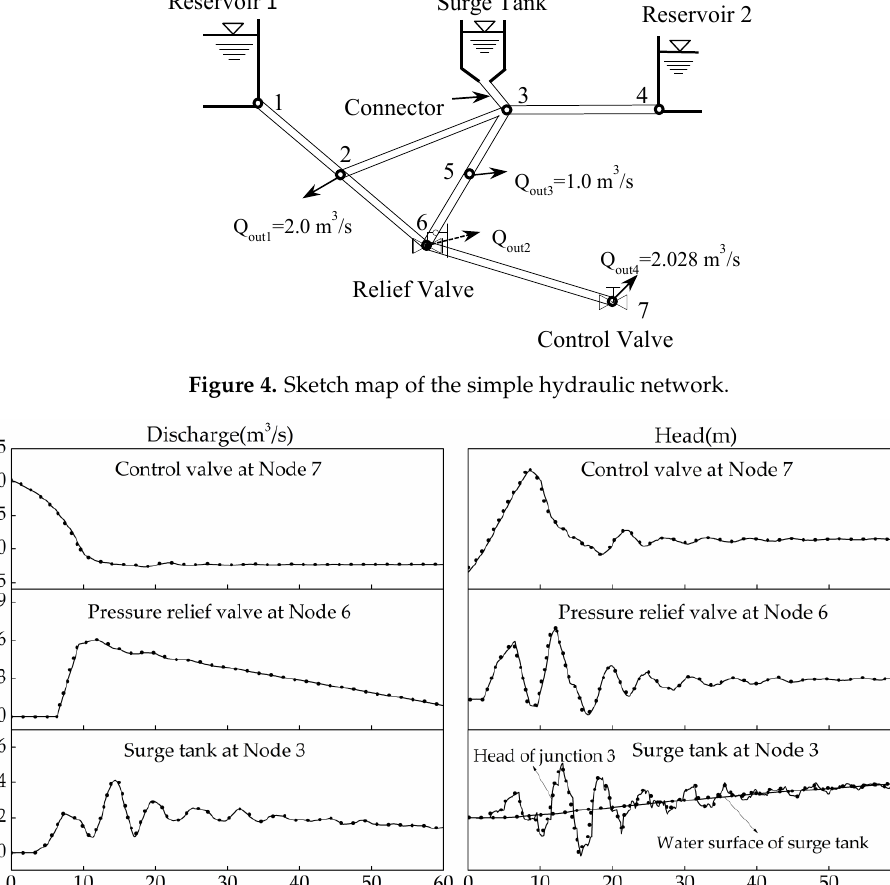
Figure 5. Comparison of head and discharge at surge tank (Node 3), pressure relief valve (Node 6), and control valve (Node 7) with data from Karney [26].